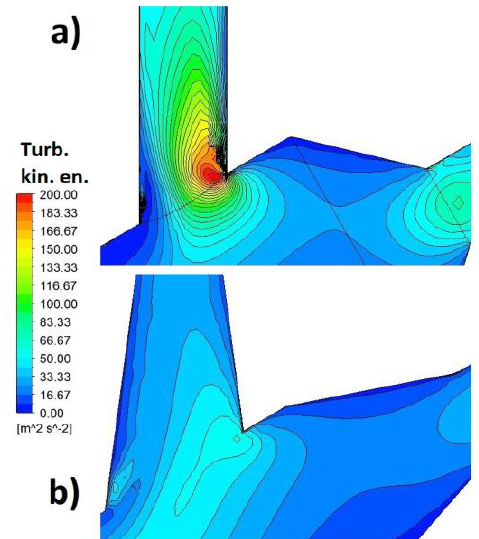
Fig. 13. Detailed contour of the turbulence kinetic energy distribution for the reference design (a) and the prototype (b) - the symmetry